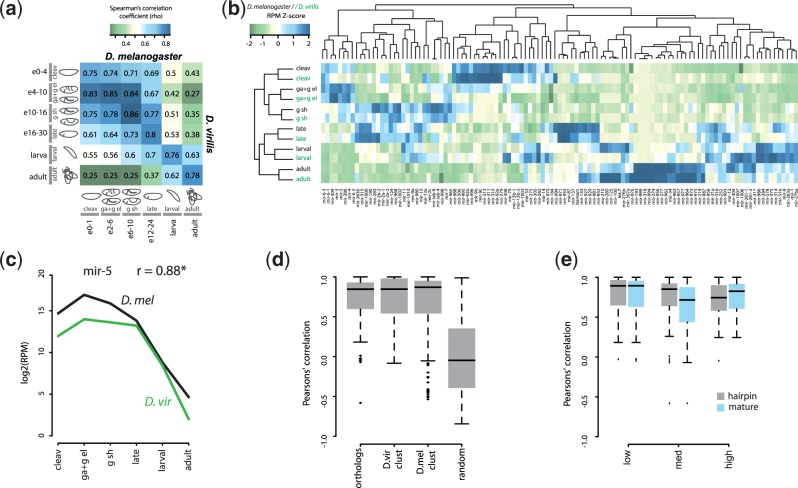
Temporal expression conservation of orthologous microRNAs between D. melanogaster and D. virilis. (a) Heatmap showing Spearman’s correlation values of microRNA expression for all-versus-all comparisons between pooled D. virilis stages (see main text) and the available D. melanogaster time intervals. (b) Heatmap showing the z-scaled expression of each orthologous microRNA at the comparable time intervals in the two species (labels are black for D. melanogaster and green for D. virilis). (c) Temporal expression of the mir-5 orthologs in the two species with calculated Pearson’s correlation (r). (d) Box plots representing the distributions of Pearson’s correlation of the temporal profiles of all orthologous pairs of microRNAs in the two species. R values for clustered microRNAs in each individual species and for randomly chosen microRNA pairs are also shown. (e) Pearson’s correlation of temporal profiles of orthologous pairs of microRNAs with low, medium, and high evolutionary rates in the whole hairpin and in the mature sequence.